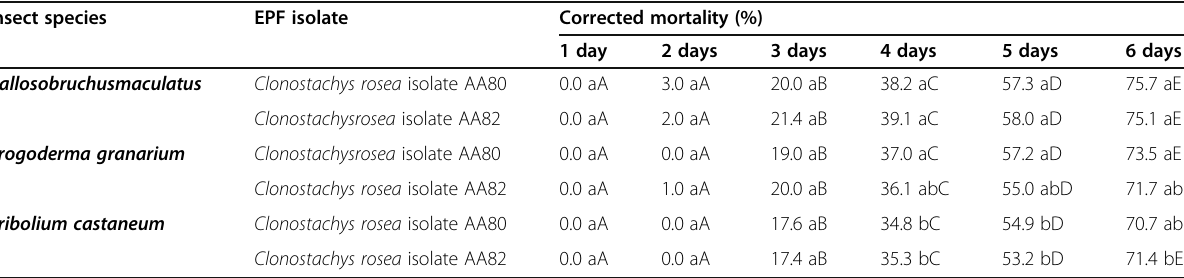
Table 1 The corrected mortalities of Callosobruchus maculatus , Trogoderma granarium and Tribolium castaneum adults treated with conidia of two Clonostachys rosea isolates. The conidial concentration of each entomopathogenic fungal isolate used for treatment